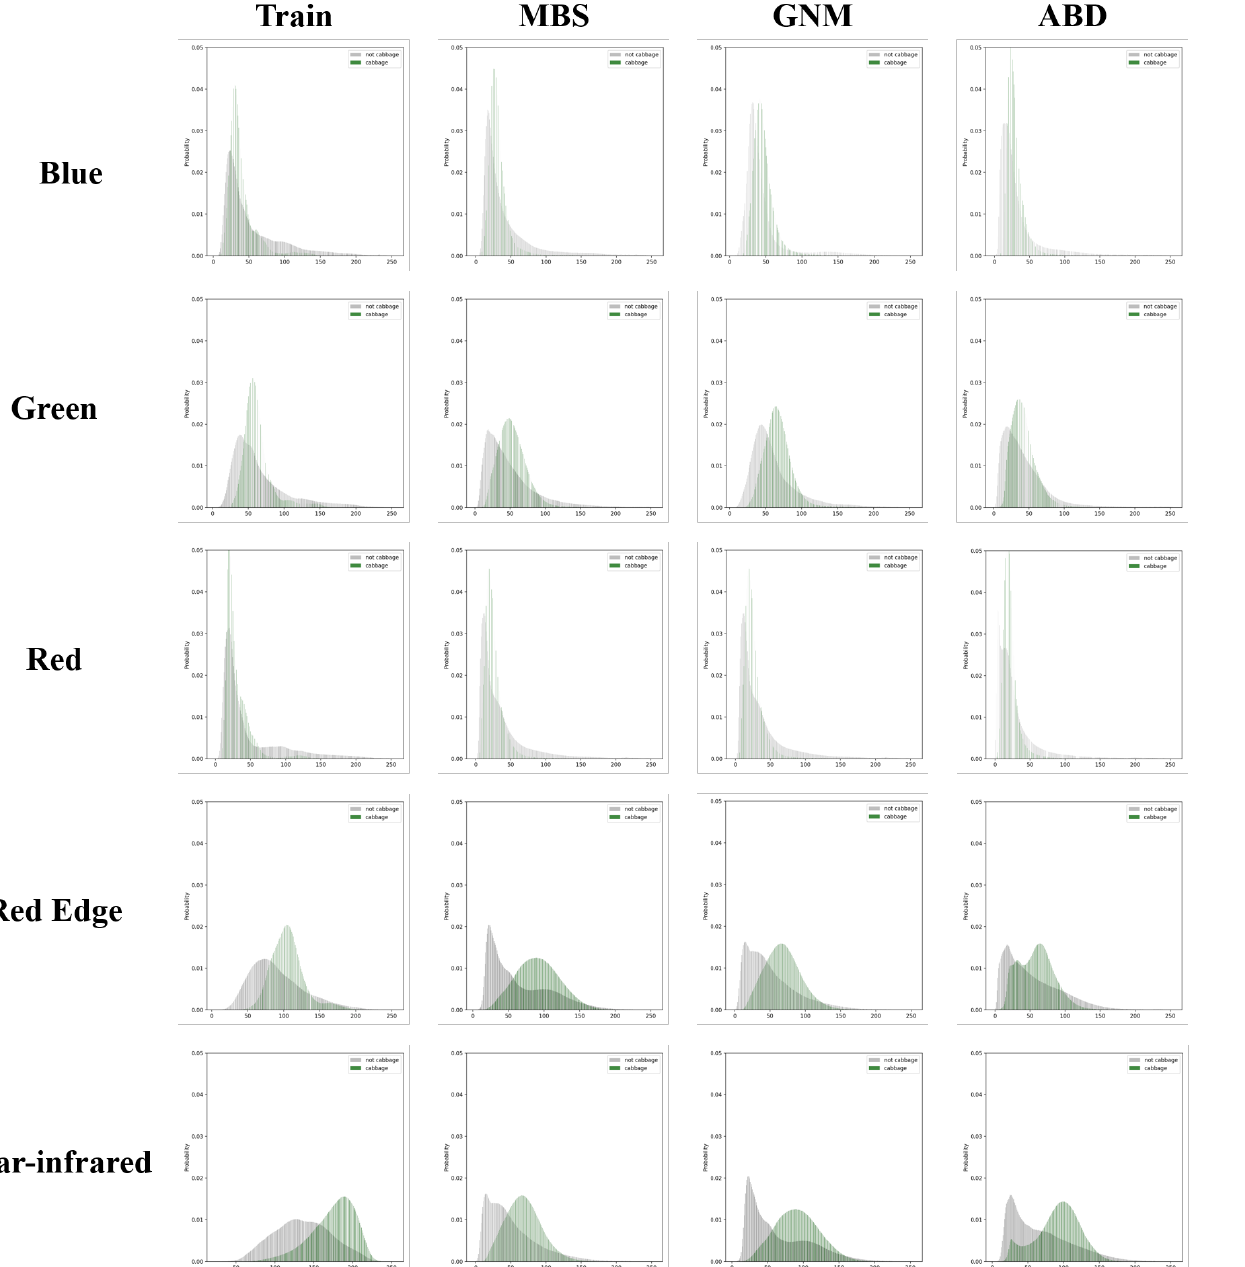
Figure 10. Reflection histograms of the each channel. Each row contains histograms for a single wavelength. Each column corresponds to a dataset. Green and gray distributions correspond to the distribution of cabbage-pixel reflection and other-pixel reflection,